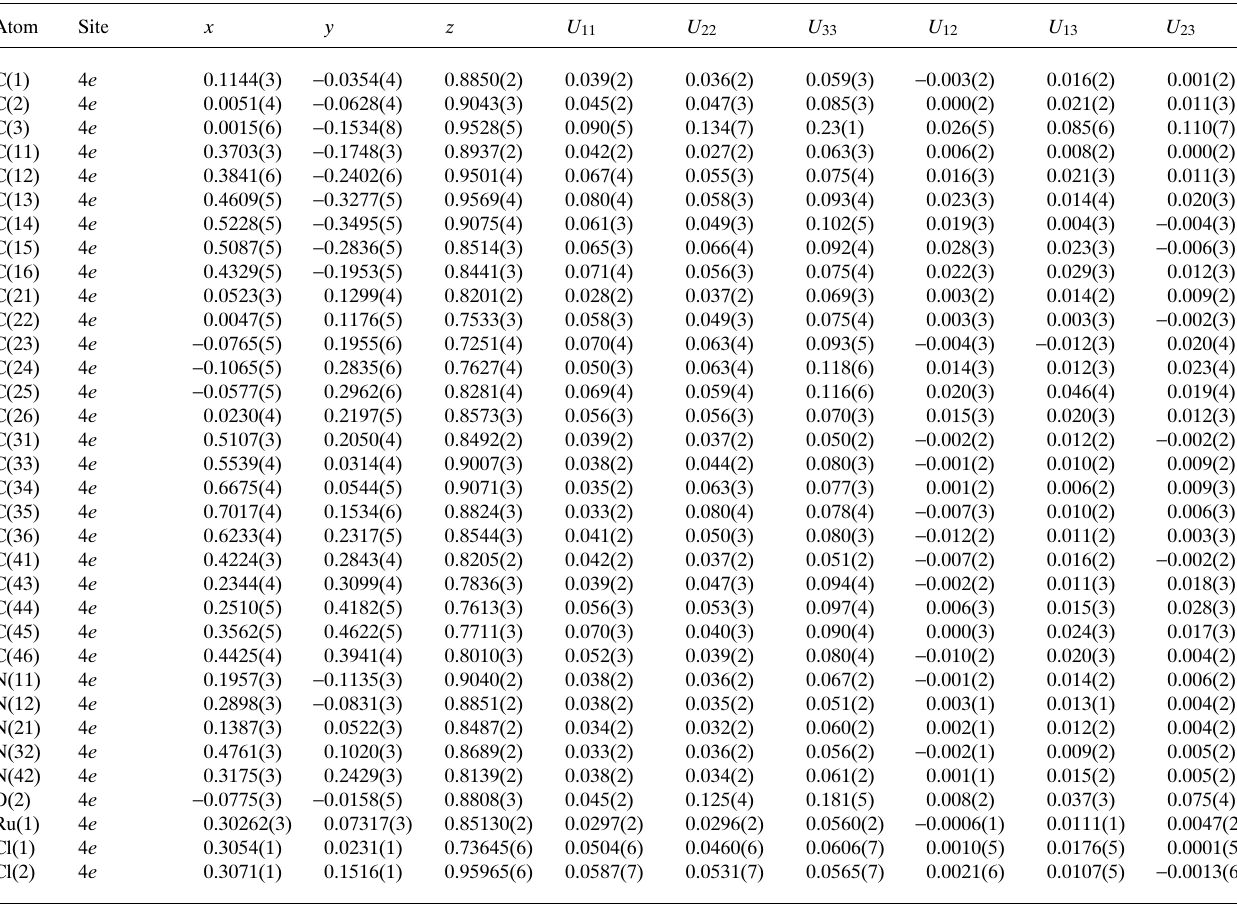
Table 3. Atomic coordinates and displacement parameters (in Å 2 )